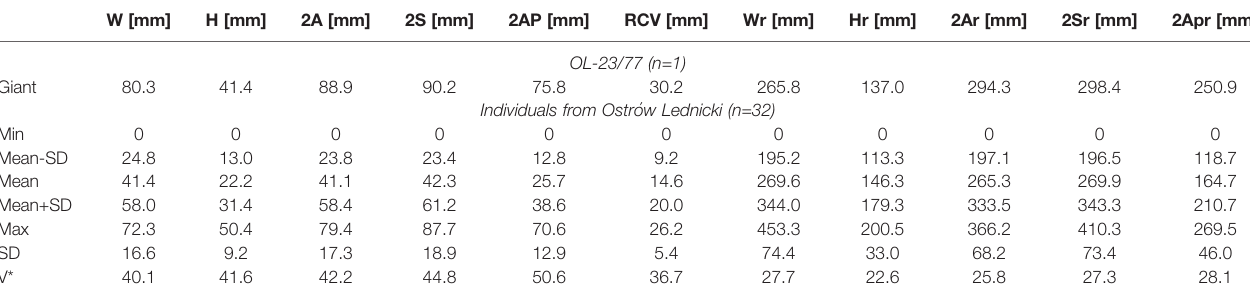
W,maximallateralextensionofthefrontalsinuses;H,maximalheightofthefrontalsinuses;2A,thecombinedmaximallengthoftheleftandrightfrontalsinuses;2S,thecombinedmaximal length of the left and right frontal sinuses; 2AP, the combined length of the left and right frontal sinuses from the most anterior point to the most posterior point; RCV, cube-root of the volumeofthefrontalsinuses;Wr,relativemaximallateralextensionofthefrontalsinusesscaledtothecuberootofthevolume;Hr,relativemaximalheightofthefrontalsinusesscaledtothe cube root of the volume; 2Ar, the combined relative maximal length of the left and right frontal sinuses in anterior view scaled to the cube root of the volume; 2Sr, the combined relative maximallengthoftheleftandrightfrontalsinusesinsuperiorviewscaledtothecuberootofthevolume;2Apr,thecombinedrelativelengthoftheleftandrightfrontalsinusesfromthemost anterior point to the most posterior point scaled to the cube root of the volume; n, number of individuals; Min, minimal observed value; Max, maximal observed value; Mean - SD, mean value minus standard deviation; Mean, mean value; Mean + SD, mean value plus standard deviation; SD, standard deviation; V*, coef fi cient of variation corrected for small sample size.